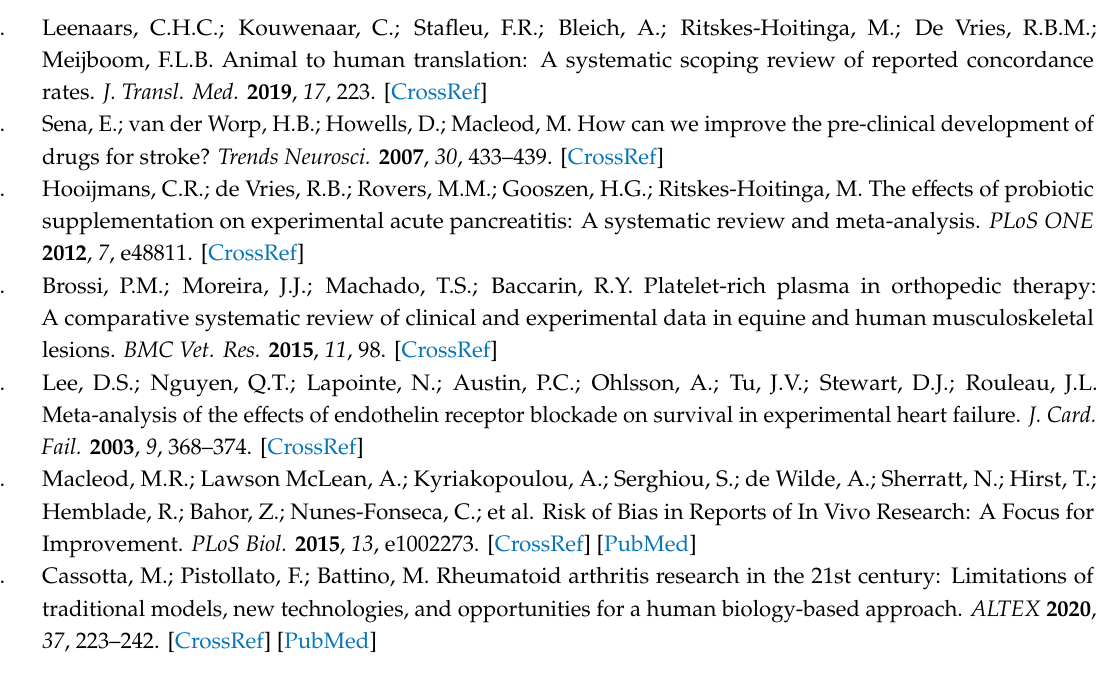
Table S1: full search strategies, Document S2: list of all included